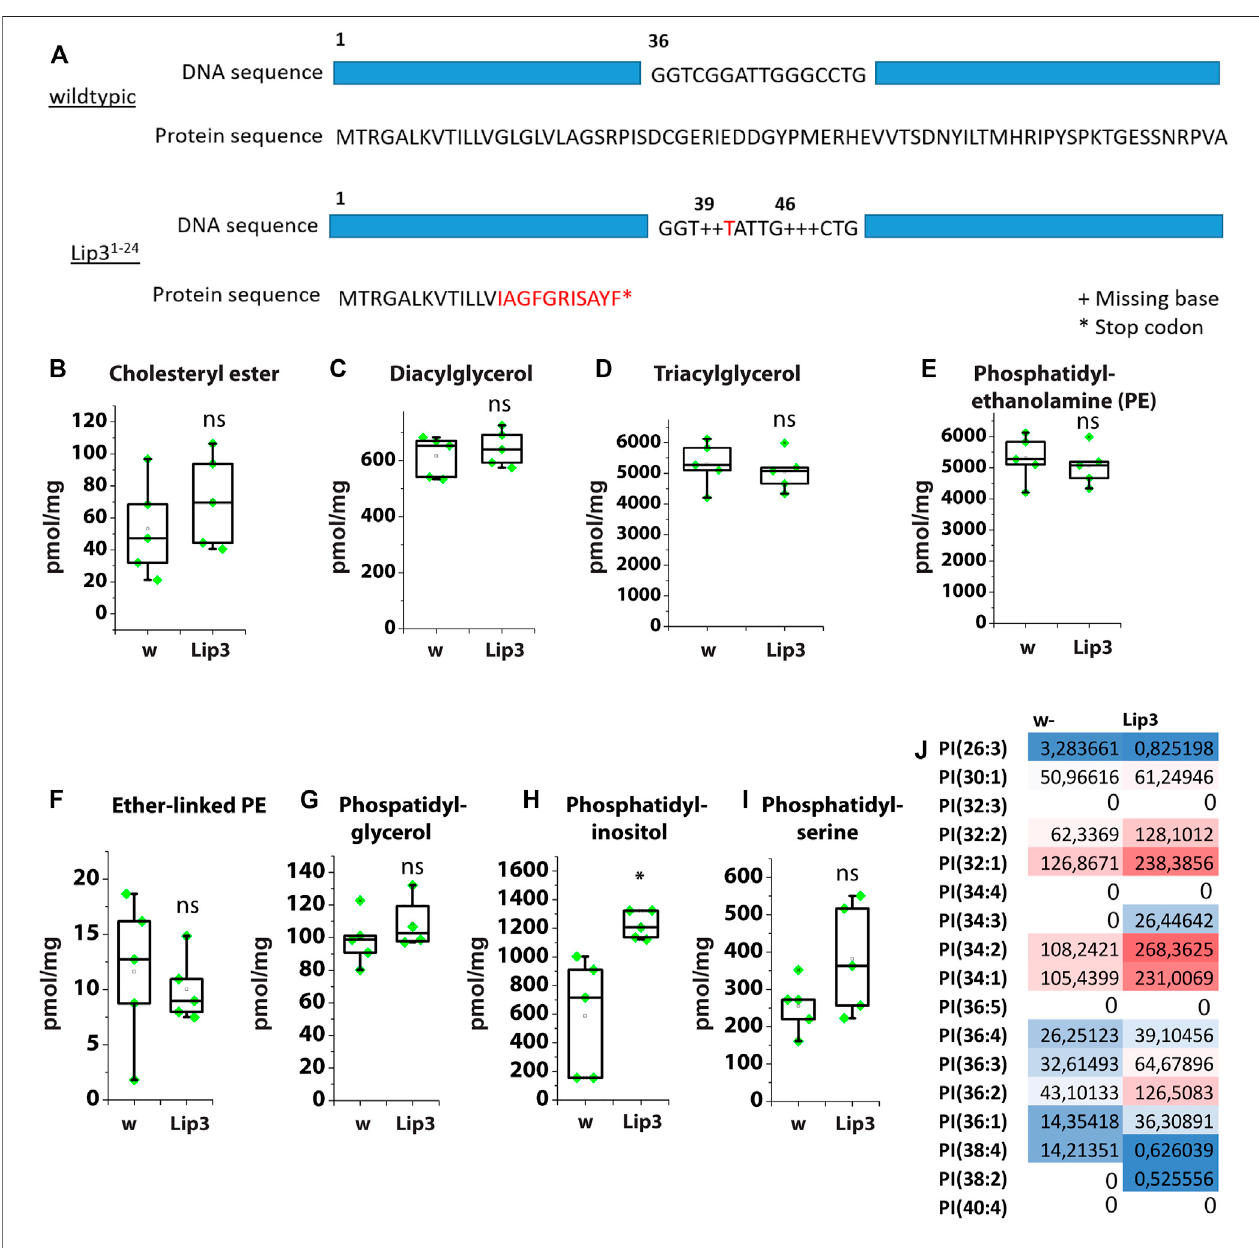
FIGURE 2 | (A) Schematic showing the mutations of the Lip3 allele Lip3 1-24 . (B) Levels of cholesteryl ester (CE), (C) diacylglycerol (DAG), (D) triacylglycerol (TAG), (E) phosphatidylethanolamine (PE), (F) Ether-linked PE, (G) phosphatidylglycerol, (H) phosphatidylinositol, (I) phosphatidylserine as determined by lipidomics in control (w) and Lip3 mutant larvae. (J) PI species in w and Lip3 mutant larvae. Asterisks represent * p < 0.05, ** p < 0.01, *** p < 0.001, ns: not signi fi cant.